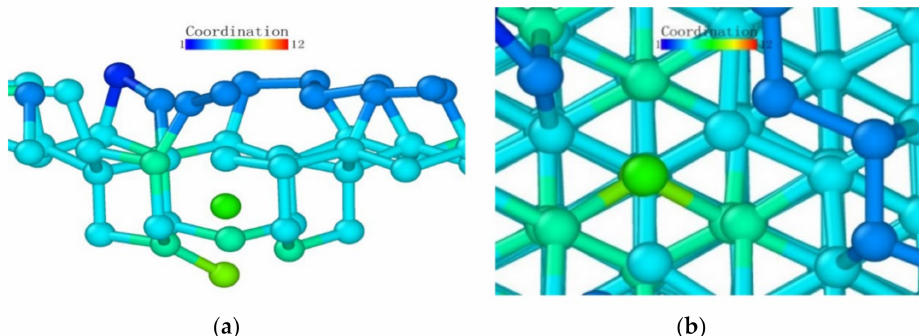
Figure 26. Atomic transient state at 0.48 nm loading stroke. ( a ) side view, ( b ) vertical view.